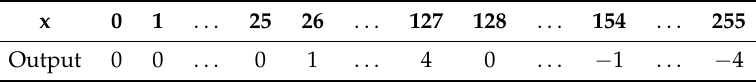
Table 2. Sampled values given random input value including the